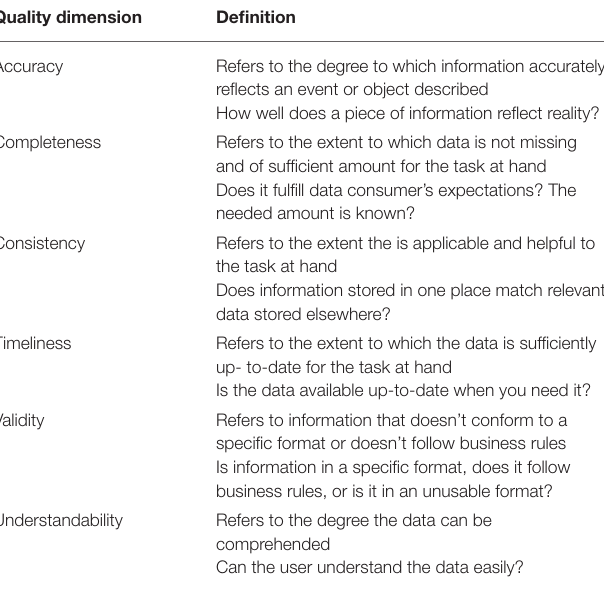
TABLE 1 | De-identified data quality dimensions definitions (DDQD). Quality